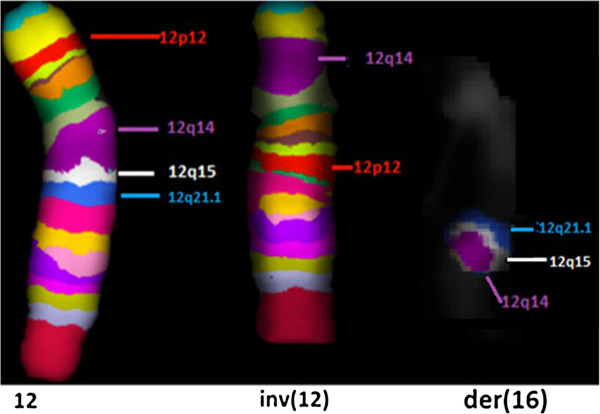
High resolution multicolour banding (MCB). High resolution MCB image of the normal chromosome 12 compared to the rearranged chromosome 12 shows that the pericentric inversion extended from the band 12p12 to the band 12q14. Chromosome 16 image shows an inverted insertion of the 12q14q21 region inside the tract 16q21q22.